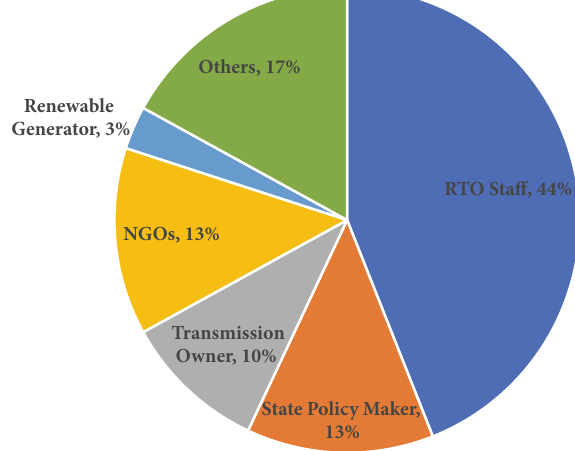
Figure 3: Distribution of respondents to semistructured